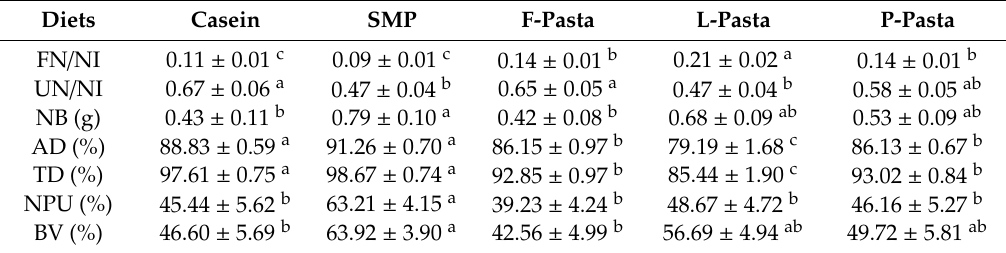
Table 4. Dietary protein quality evaluation using the nitrogen balance method in old rats after 6 weeks of diet.